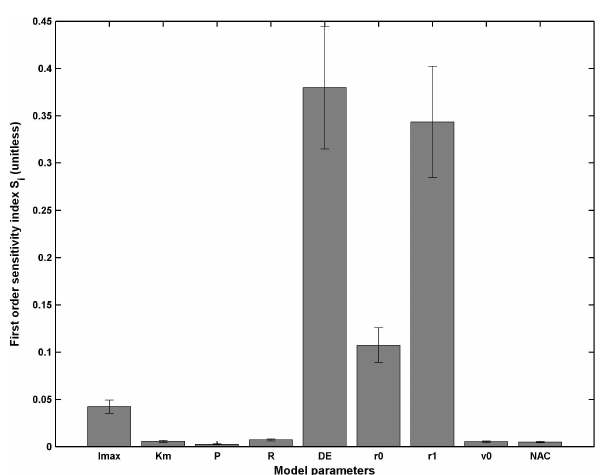
Fig. 4. The mean and standard deviation of the first order sensitivity index ( S i ) of organic nitrogen uptake by plants with respect to each selected controlling parameter (Table